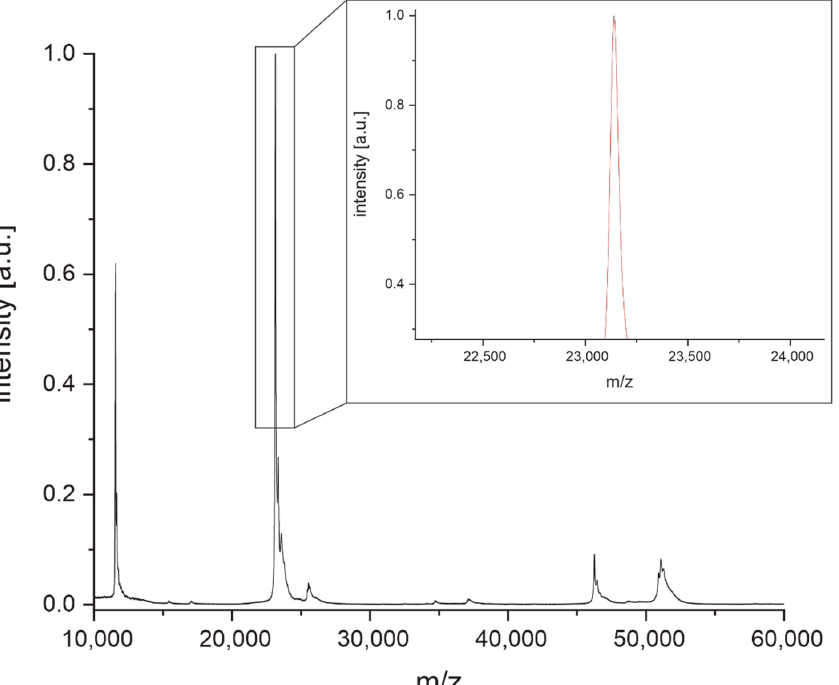
Figure 3. MALDI-TOF mass spectrum of NIST-mAb 8671 after cleavage of intermolecular disulfide bonds. The mass of the light chain was determined using a Savitzky-Golay filter with 50 points (inset, red curve) followed by manual peak picking of the maximum.